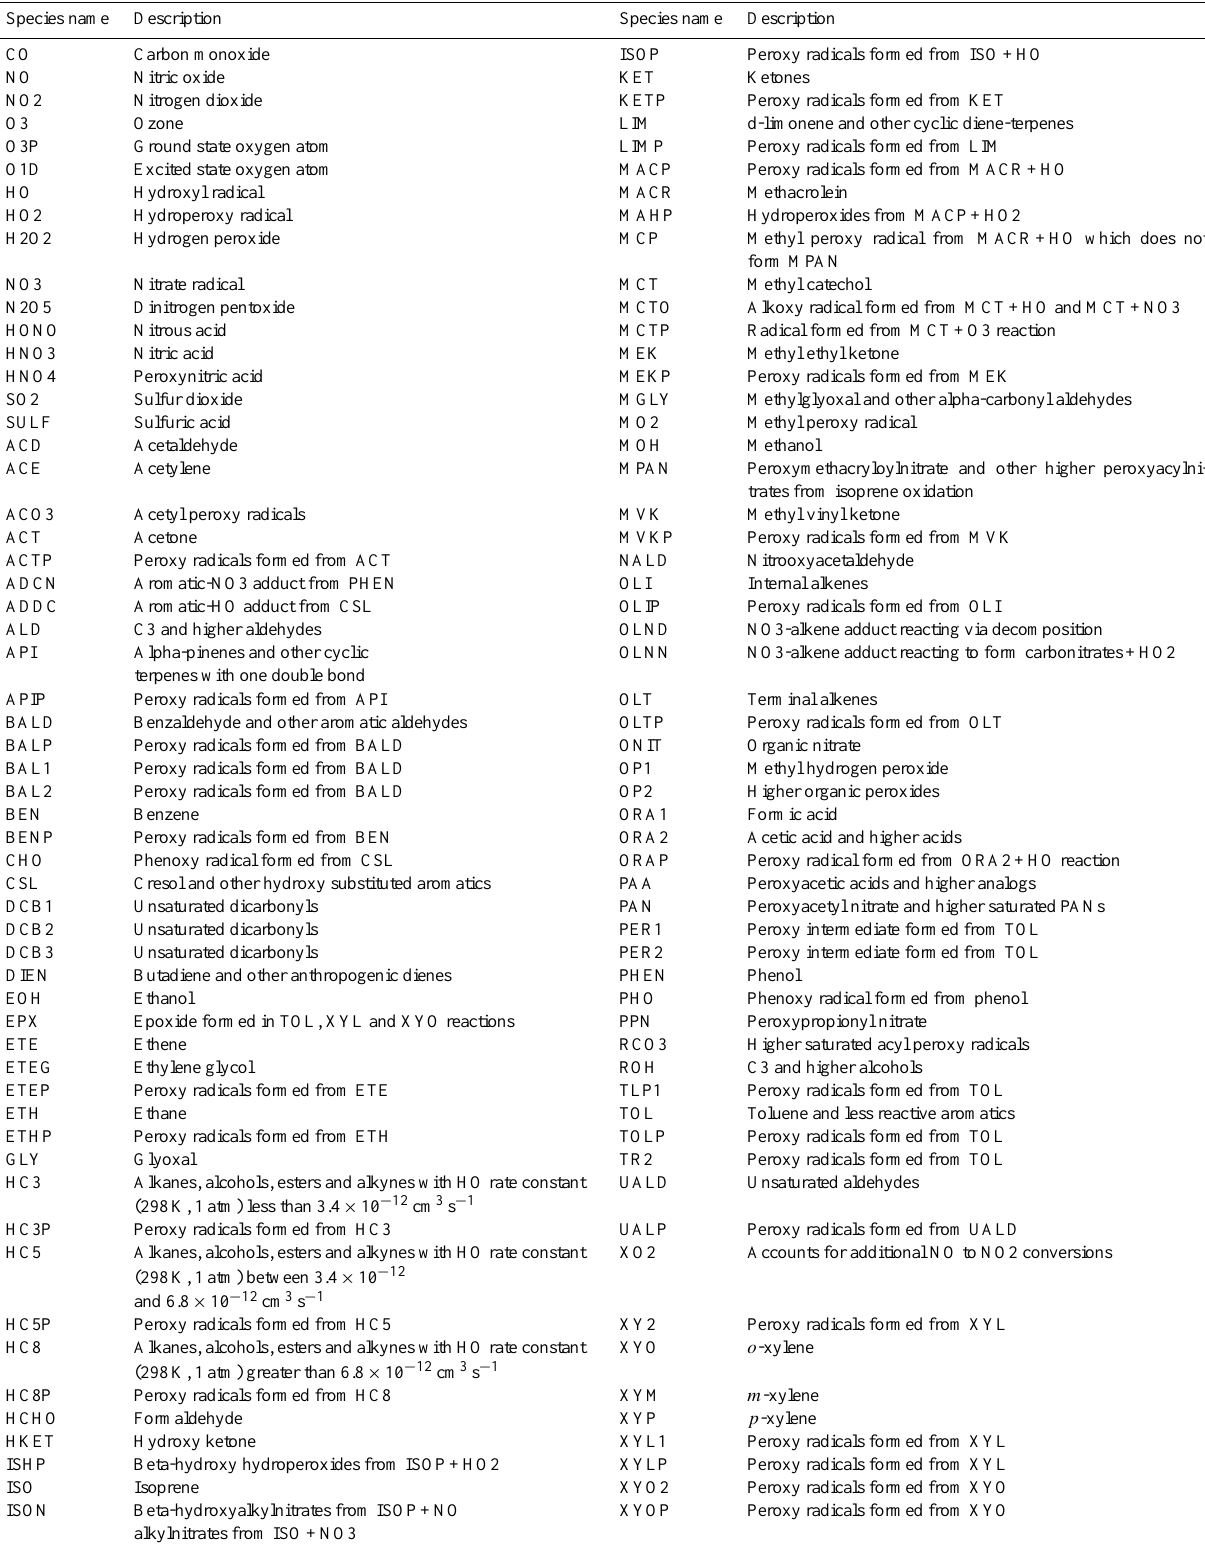
Table 2. Model chemical species in RACM2 ∗ (Goliff et al.,